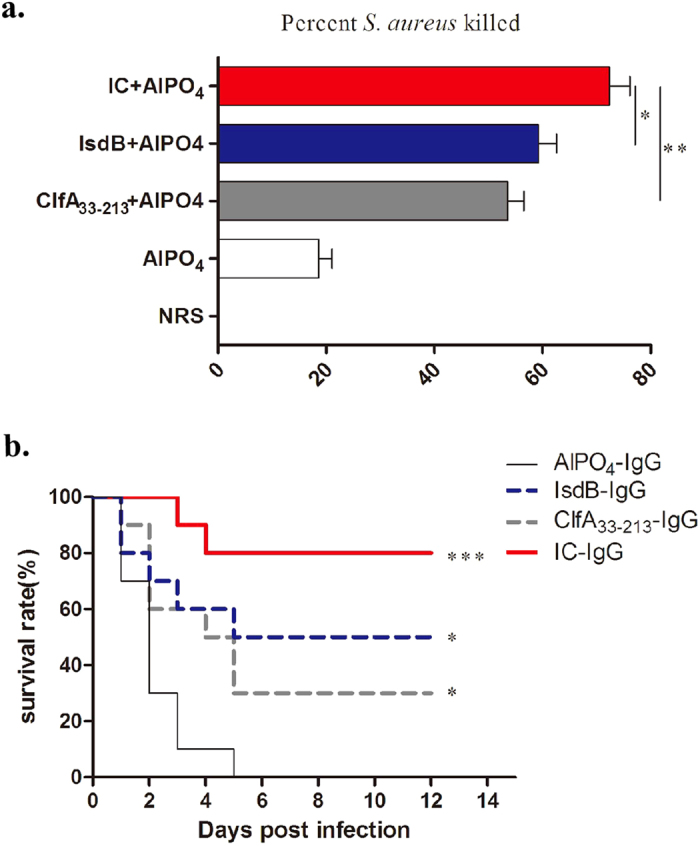
Opsonophagocytic assays and passive immunisation.Rabbits (n = 6) were immunised with AlPO4, IsdB, ClfA33-213 and IC, serum was separated. (a) The results of opsonophagocytic assays were shown. Rabbit serum (1:5 diluted), fetal rabbit complement, HL60 cells, and MRSA 252 were incubated in round bottom 96-well plates with shaking, and plated on tryptic soy broth to measure bacterial survival counted by CFUs, then the percent of killing was calculated. Normal rabbit serum was used as blank control. Error bars represent the SD. (b) Survival rates of passive immunisation were shown. Antibodies specific IgG in the rabbit serum was purified. One day before infection, BALB/c mice (n = 10) were passively immunised intraperitoneally (i.p.) with 5 mg of the IgG fraction containing antibodies specific for IC, IsdB, ClfA33-213 and AlPO4, respectively. Mice were challenged with lethal dose of MRSA 252 (1 × 109 CFUs), survival rates were monitored for 12 days. The significance of the protective immunity generated by the various antigens was measured with a log rank test compared with AlPO4 group. The asterisks represent a statistically significant difference (*P < 0.05, **P < 0.01, ***P < 0.001).